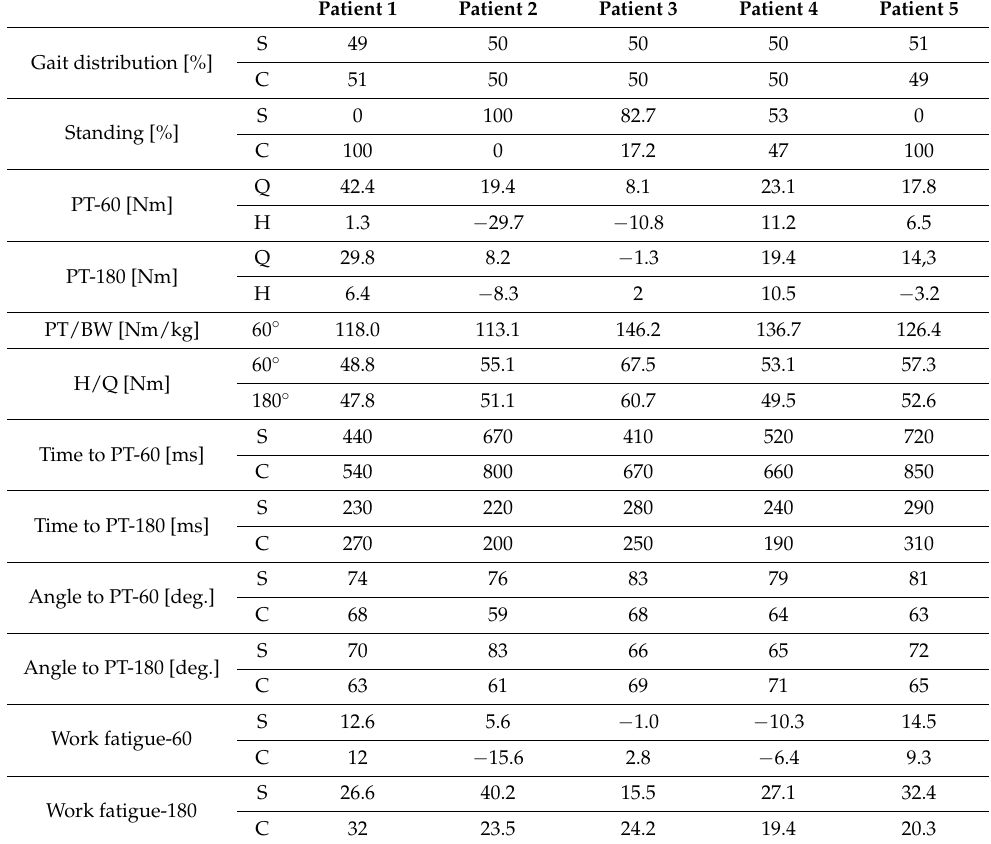
Table 3. Isokinetic